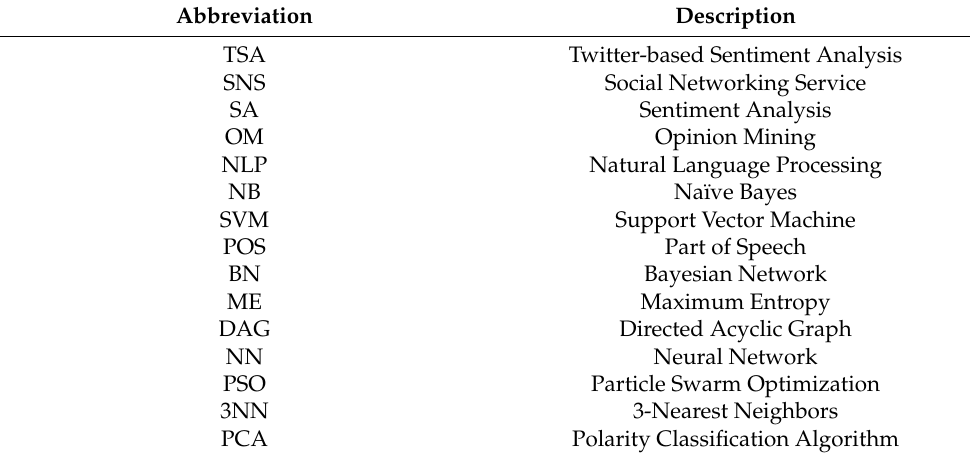
Table 1. The description of